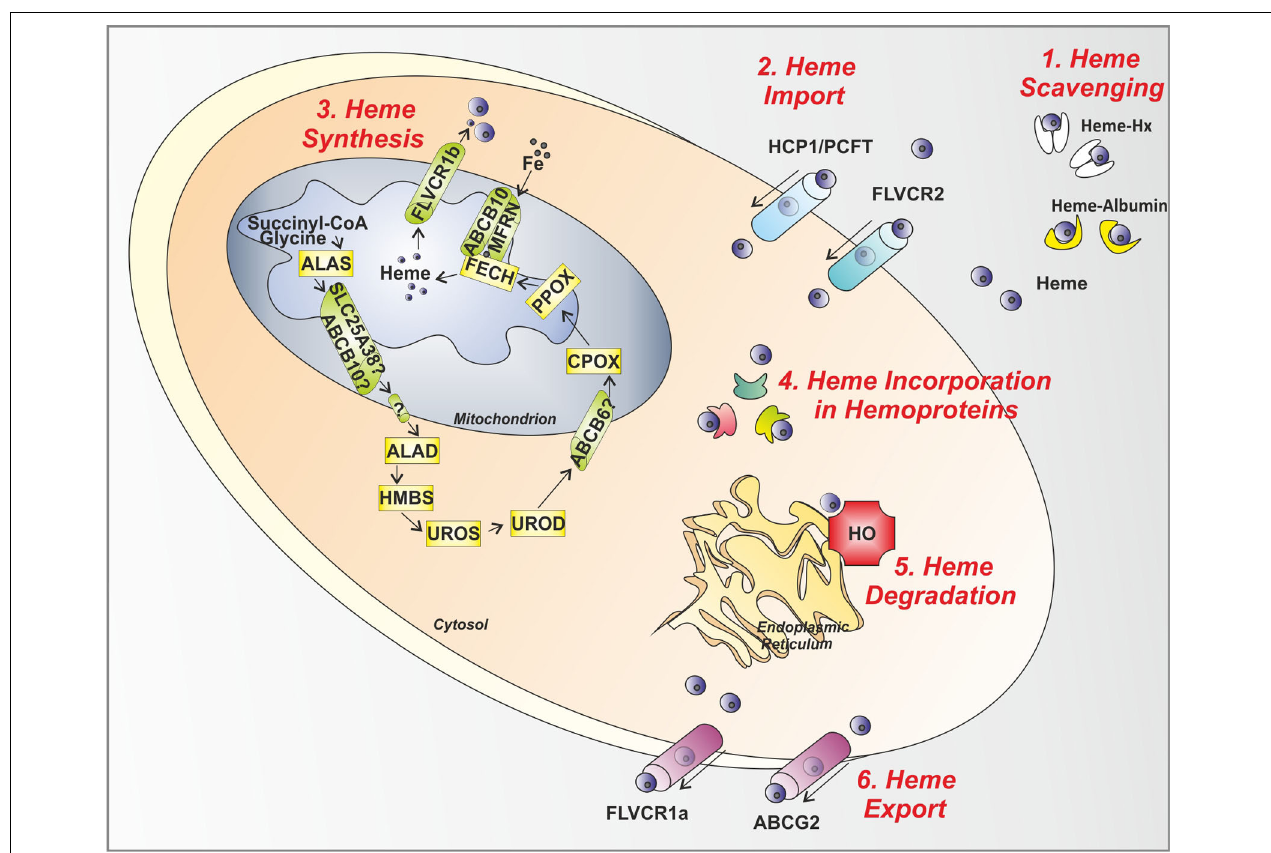
FIGURE 2 | Control steps in heme metabolism. The main mechanisms involved in the control of heme levels outside, inside and across the cell are illustrated. (1) Heme scavenging: Circulating free heme toxicity is avoided thanks to the action of the scavenging proteins Hx and Albumin. (2) Heme Import: Heme might be imported inside the cell via the putative heme importers HCP1/PCFT and FLVCR2. (3) Heme Synthesis: in the mitochondrion and cytosol, the heme biosynthetic enzymes, starting from succinyl-CoA and glycine, give rise to heme. After synthesis, heme is exported out of the mitochondrion to the cytosol by the mitochondrial heme exporter FLVCR1b. (4) Heme Incorporation in Hemoproteins: once released in the cytosol, heme is inserted in apo-hemoproteins to allow the formation of functional hemoproteins. (5) Heme Degradation: in the endoplasmic reticulum, the heme